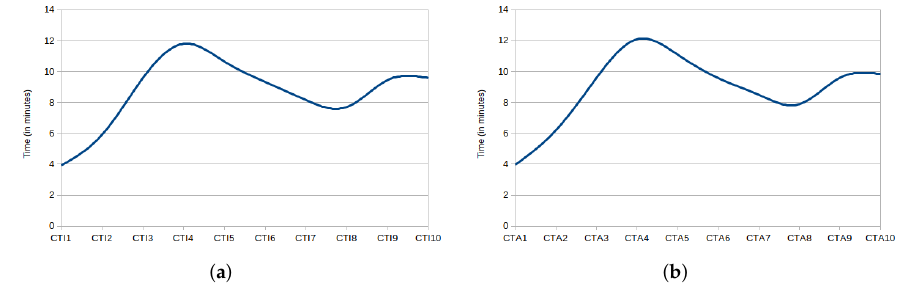
Figure 12. Performance evaluation on contract creation and audit. ( a ) Time spent on contract creation. ( b ) Time spent on contract audit.